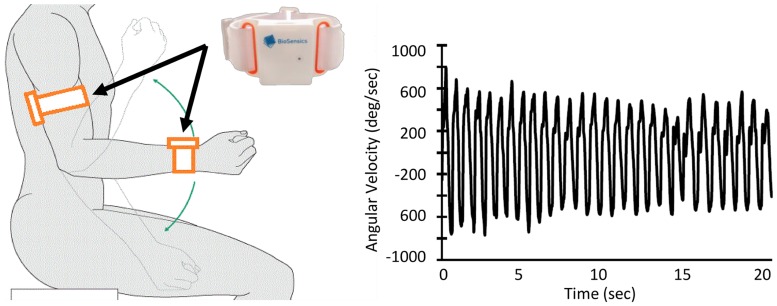
UEF experimental setup and sensors output (i.e., elbow angular velocity).